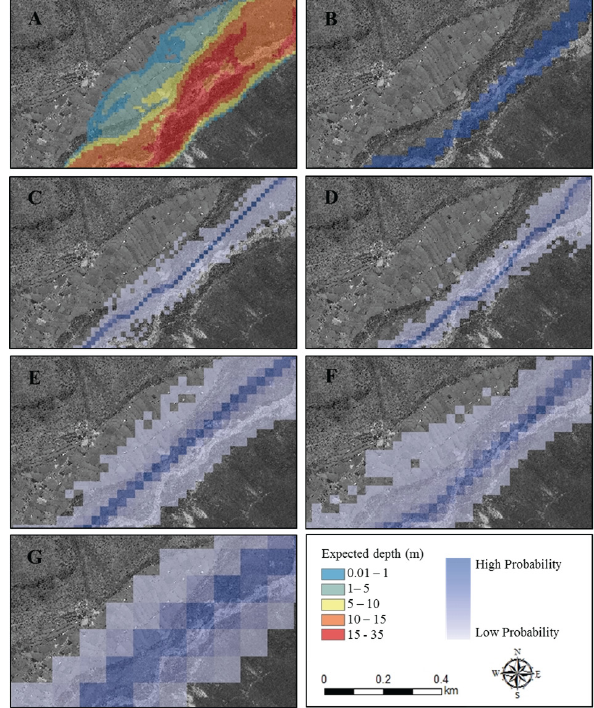
Figure 3. Inundated areas at Dingboche for a GLOF from Imja Tsho using (a) FLO2D (Somos-Valenzuela et al., 2015), (b) the MSF model using the GDEM, and (c–g) the MC-LCP model with var- ious DEMs and pixel sizes: (c) SRTM 90m resampled 15m, (d) GDEM 30m resampled 15m, (e) SRTM 90m resampled 30m, (f) GDEM 30m, and (g) SRTM